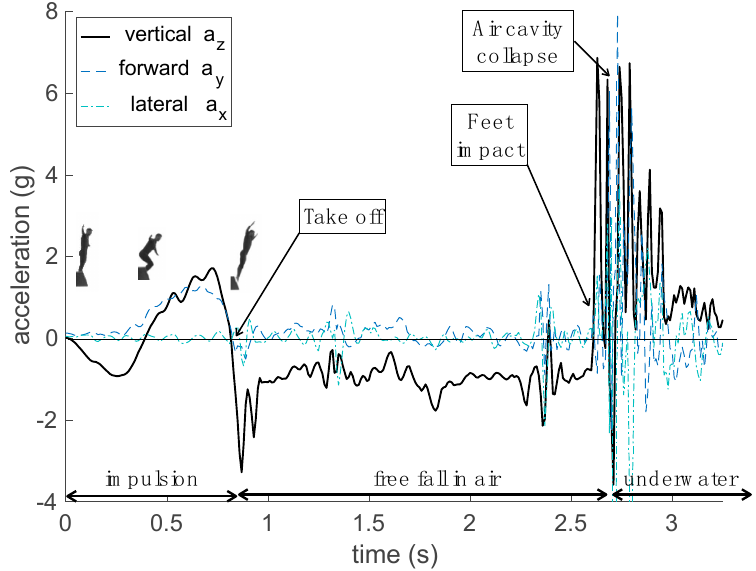
Figure 3. Time evolution of the acceleration of the diver during the whole dive (aerial and underwater) in the three direction: vertical (- a (cid:2936) ), forward ( a (cid:2934) ) and lateral ( a (cid:2935) ). Time origin is taken at the beginning of the impulsion. The measured vertical acceleration is orientated upwards (gravity g